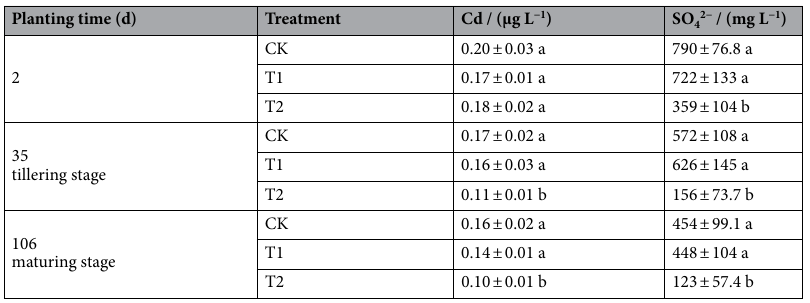
Table 1. Changes in Cd and SO 4 2- concentrations in soil solutions at different growth stages. Treatments: no azolla (CK), azolla culturing in the water layer and intercropping with rice (T1), azolla incorporated into soil before rice transplantation (T2). Different letters represented significant difference at P < 0.05.